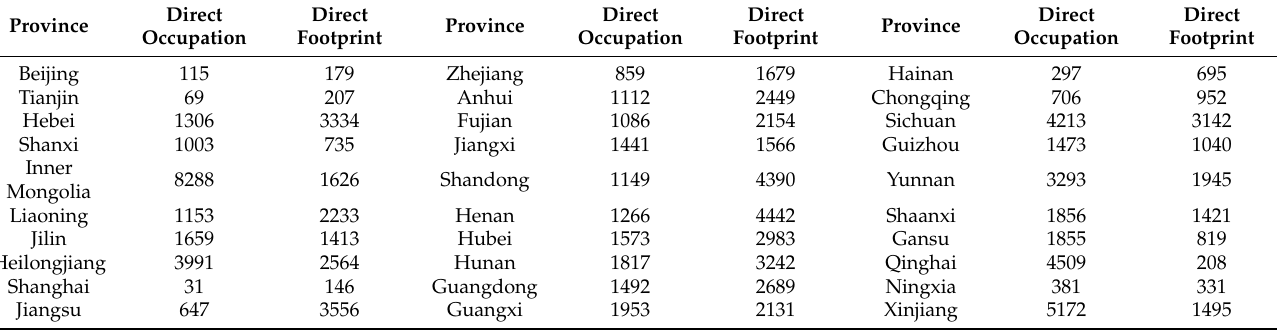
Table 3. Direct agricultural occupation and direct agricultural land footprint (10 4